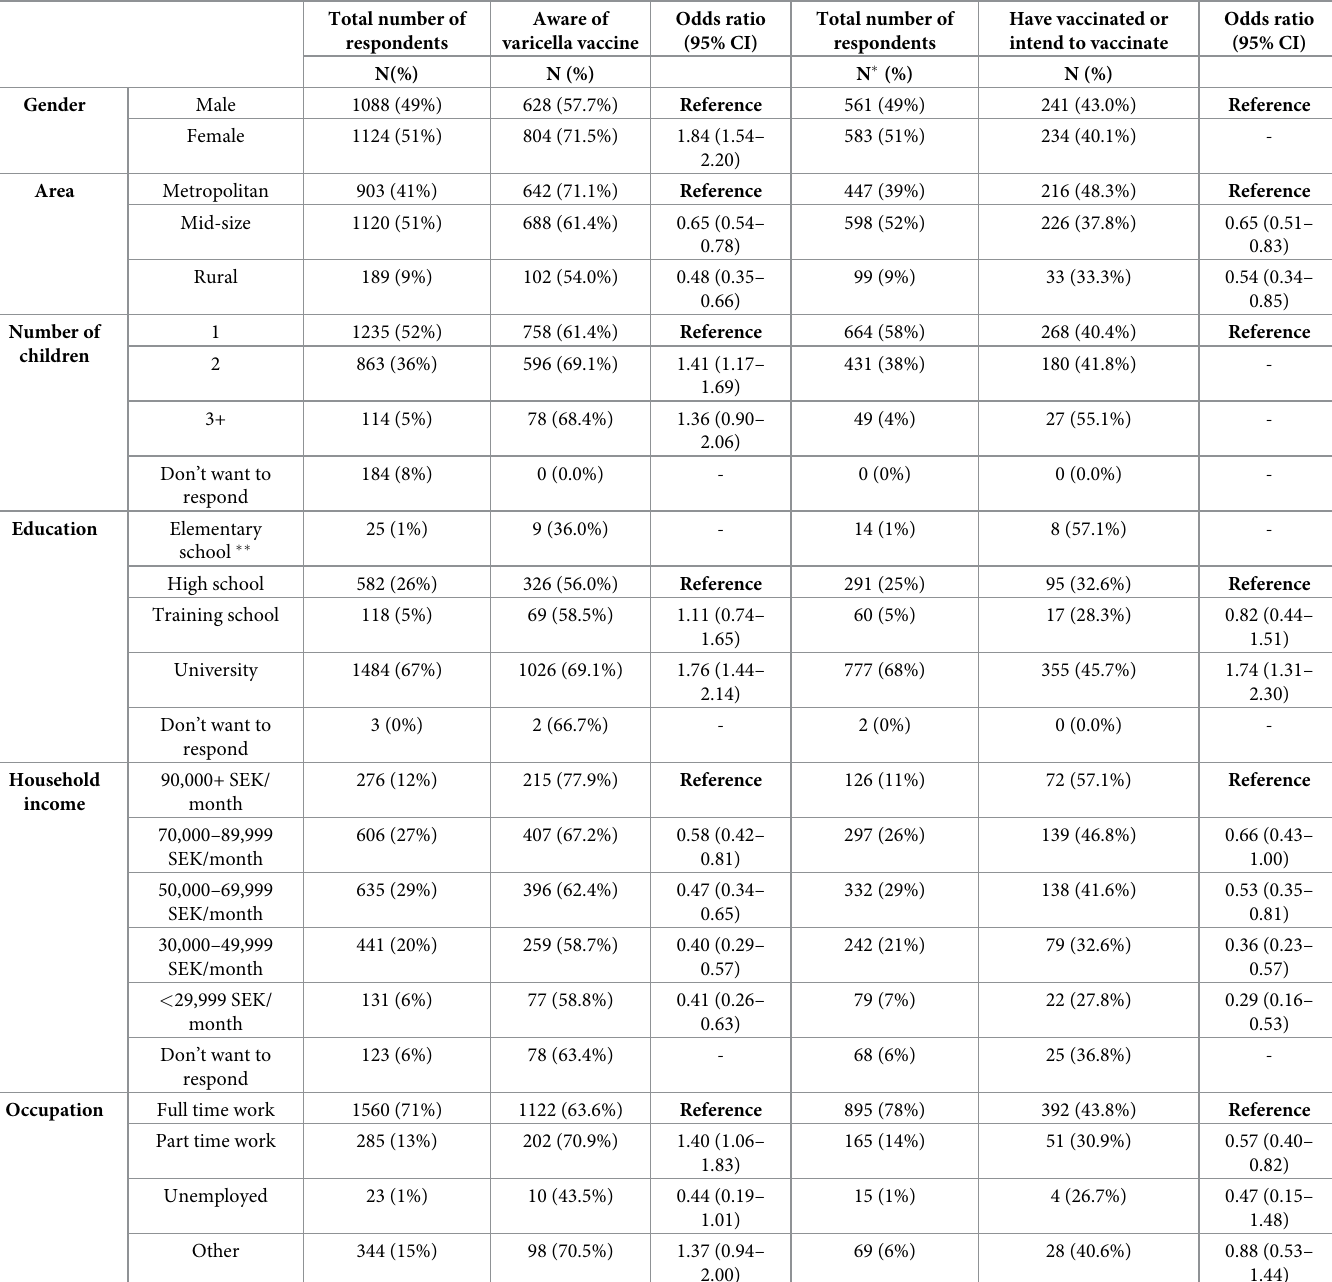
Table 3. Odds ratio analysis of awareness of varicella vaccine and vaccination status for all significant variables based on Chi-squared